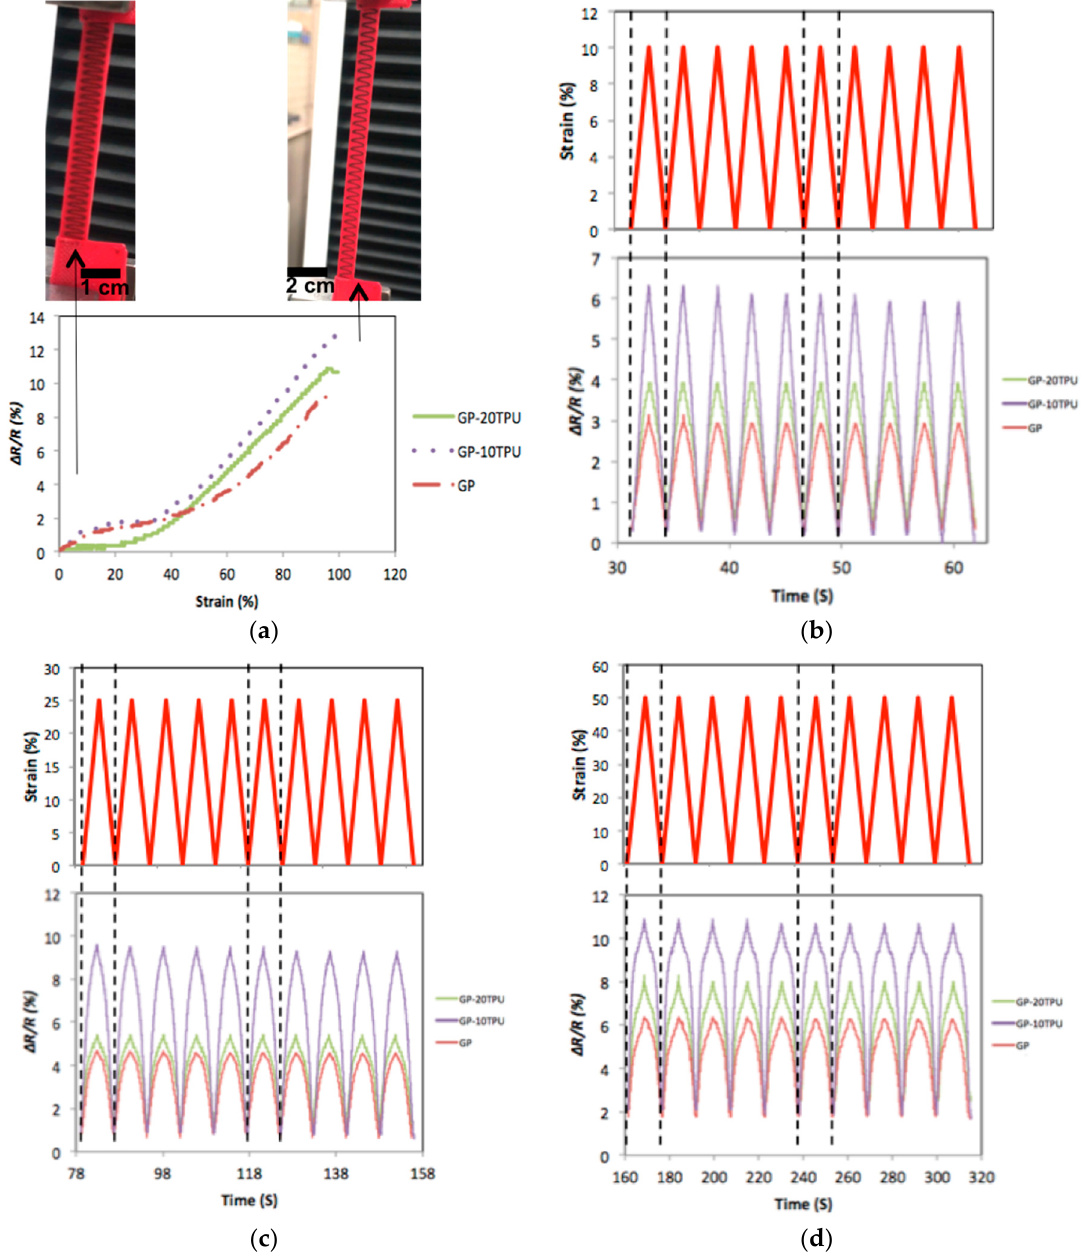
Figure 2. ( a ) First response of change in resistance at 100% strain (inset of the sample at 0 & 100% strain); ( b ) cyclic loading at 10% strain; ( c ) cyclic loading at 25% Strain; ( d ) cyclic loading at 50%